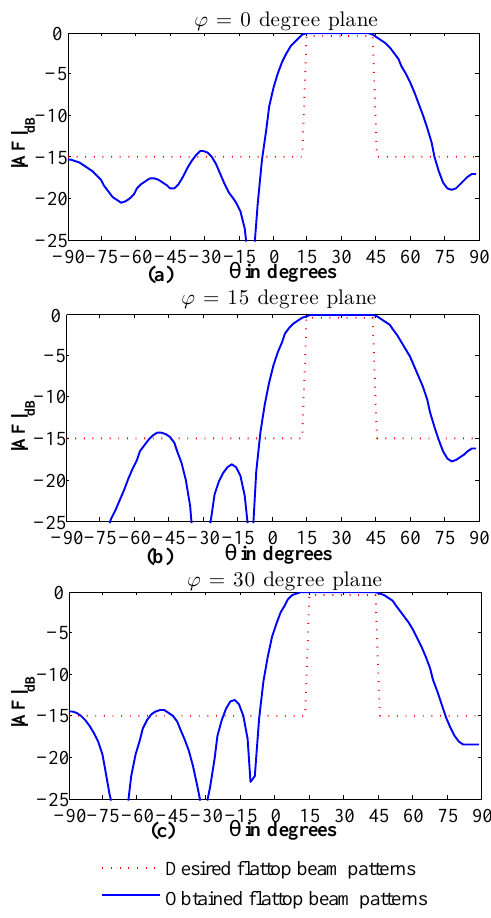
Figure 3: Scanned Flat-top patterns after removing the weakly excited elements from the array (a) ϕ = 0 o (b) ϕ = 15 o (c) ϕ = 30 o